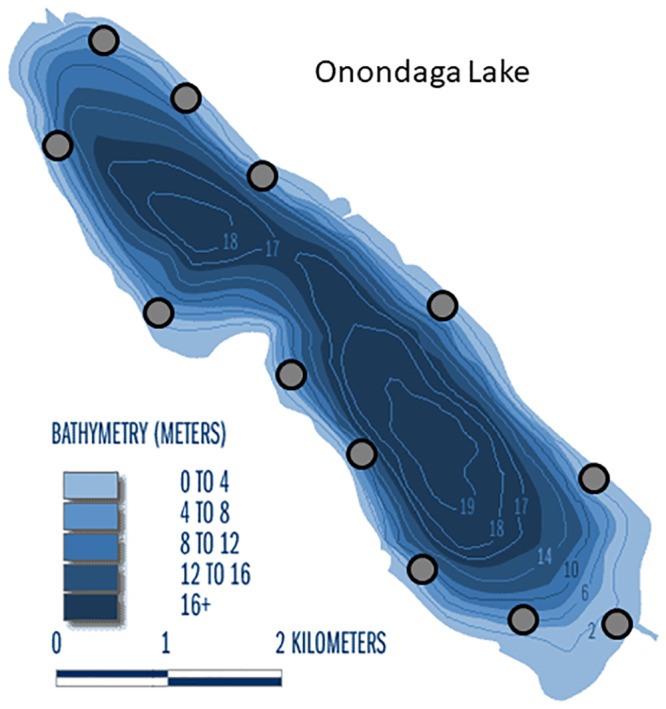
Onondaga Lake mussel sampling sites.Three (2005–2010, depth 0–4.5 m), four (2011–2012, depths 0–6 m), five (2013, depths 0–7.5 m) or six (2014, depths 0–9 m) samples were collected at each site with one sample collected per 1.5 m depth layer.